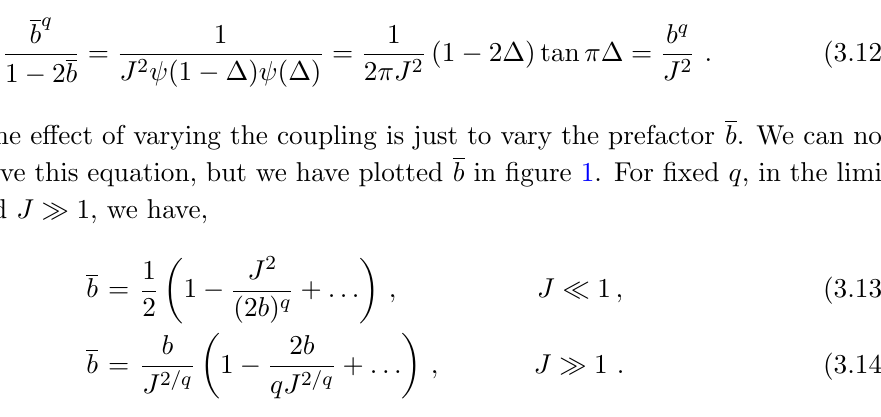
Figure 1 . (a) A plot of the running of the normalization of the cSYK fermion two-point function, b , as a function of J , for q = 8 ; 6 ; 4. The larger the q , the slower the decay. (b) A plot of b decreases with increasing q (the opposite of b